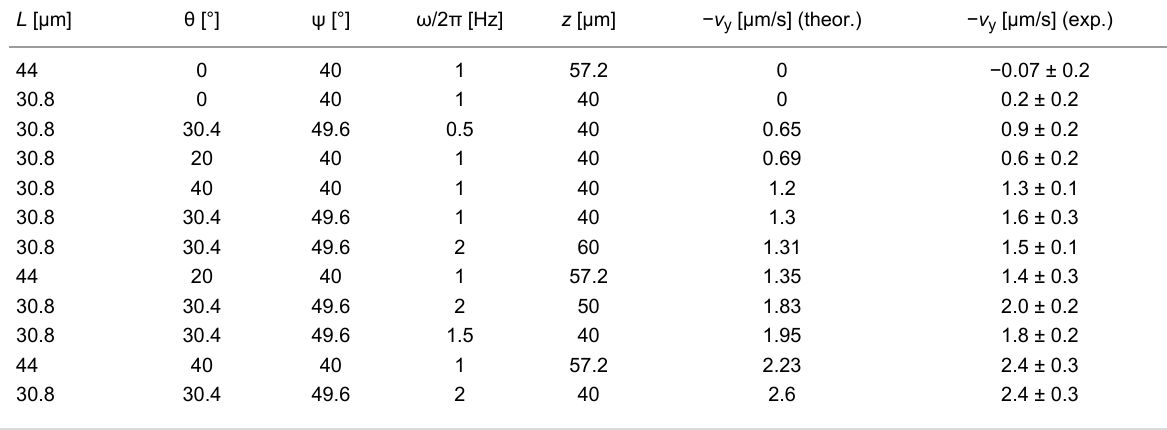
Table 1: Experimental parameters, and theoretical and experimental values of the average velocity as shown in Figure 3.